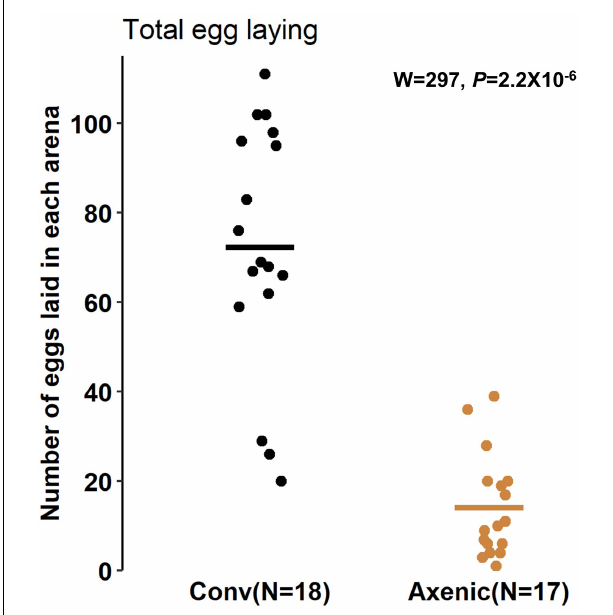
FIGURE 3 | Oviposition of conventional and axenic Drosophila suzukii . The total number of eggs laid on the fruits after 24 h in the arenas (Mann–Whitney U